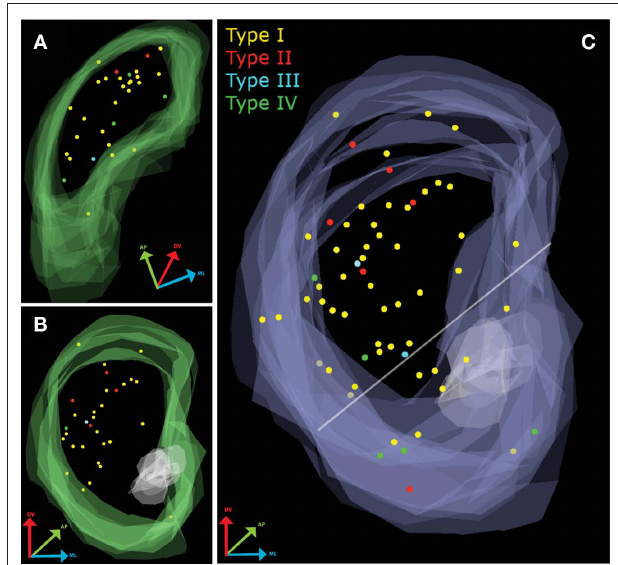
FiGure 1 | Mapping of electrophysiologically characterized and biocytin-filled TH-eGFP neurons in the striatum. (A) Overlay of all parahorizontal sections ( n = 32). (B) Overlay of all coronal sections ( n = 31). (C) Merged data set after rotating the parahorizontal sections 10 ° from their long axis and 90 ° around their